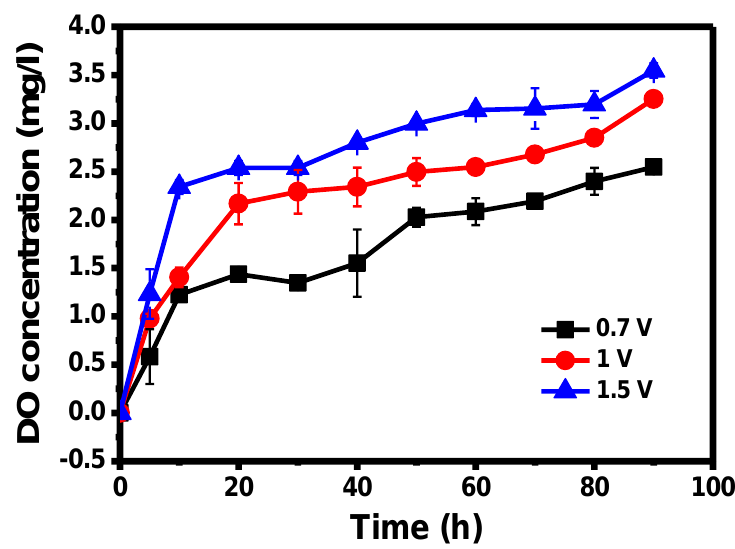
Figure 2. The variation in dissolved oxygen (DO) concentrations with respect to the time noted with change in applied voltage.